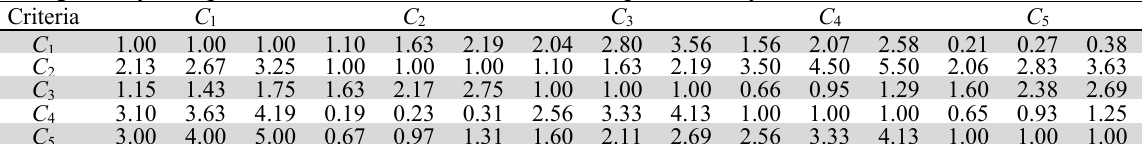
Average fuzzy comparison matrix of lecturers’ research productivity evaluation criteria Criteria C 1 C 2